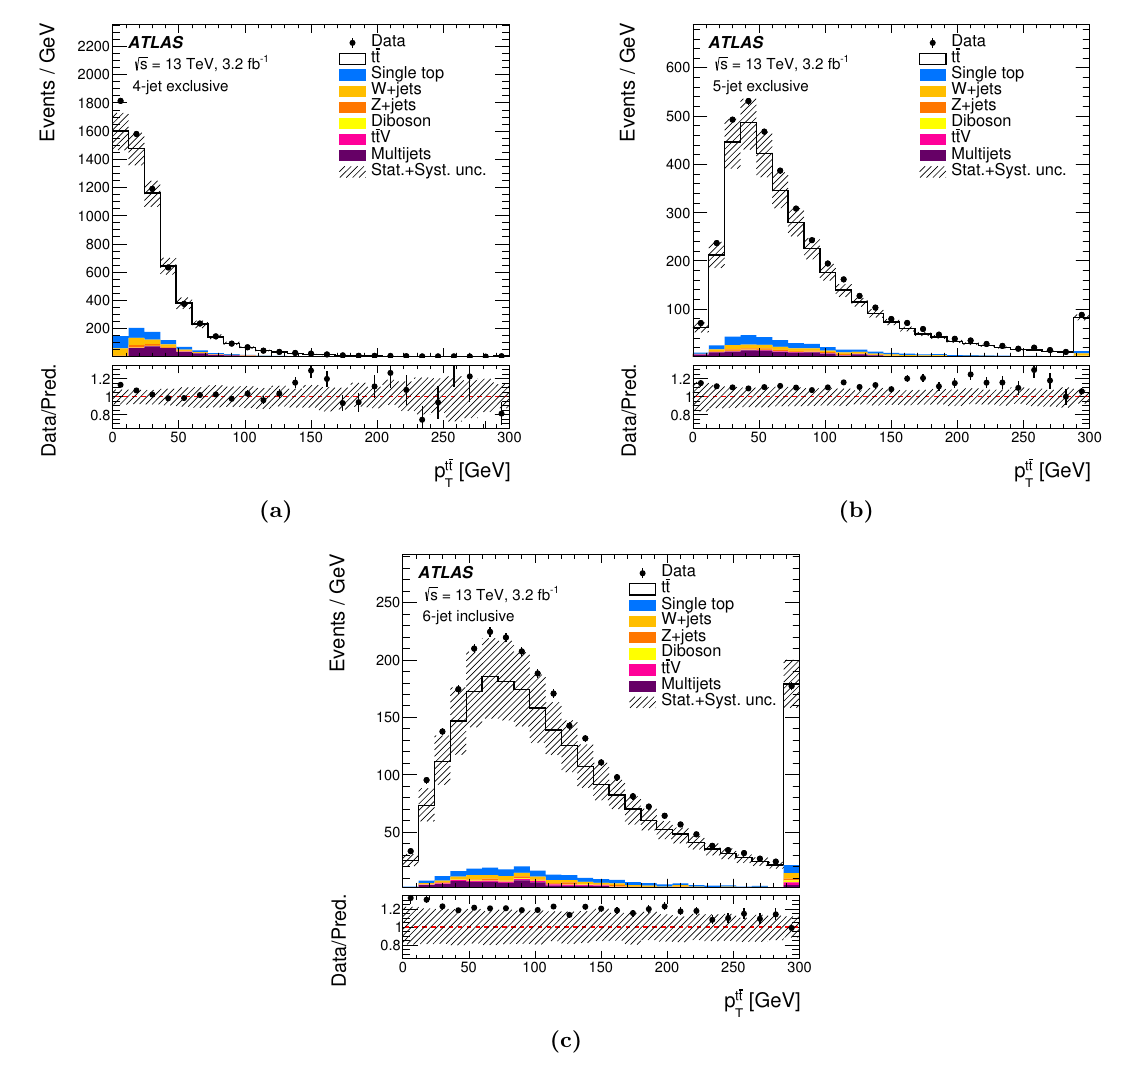
Figure 4 . Distributions of p t (cid:22) t at reconstruction level: (a) 4-jet exclusive, (b) 5-jet exclusive and (c) T 6-jet inclusive con(cid:12)gurations. Data are compared to the sum of signal and background predictions using the nominal sample as the t (cid:22) t signal model. The hatched area indicates the combined statistical and systematic uncertainties in the total prediction, excluding systematic uncertainties related to the modelling of the t (cid:22) t production. Events beyond the range of the horizontal axis are included in the last